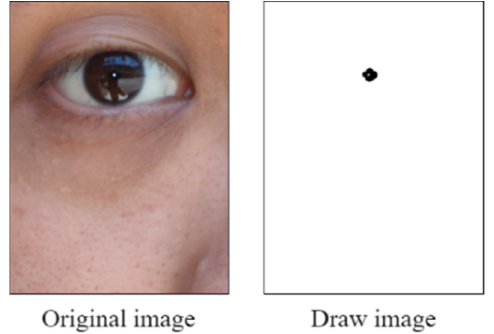
Figure 27. Matrix area below the red threshold.